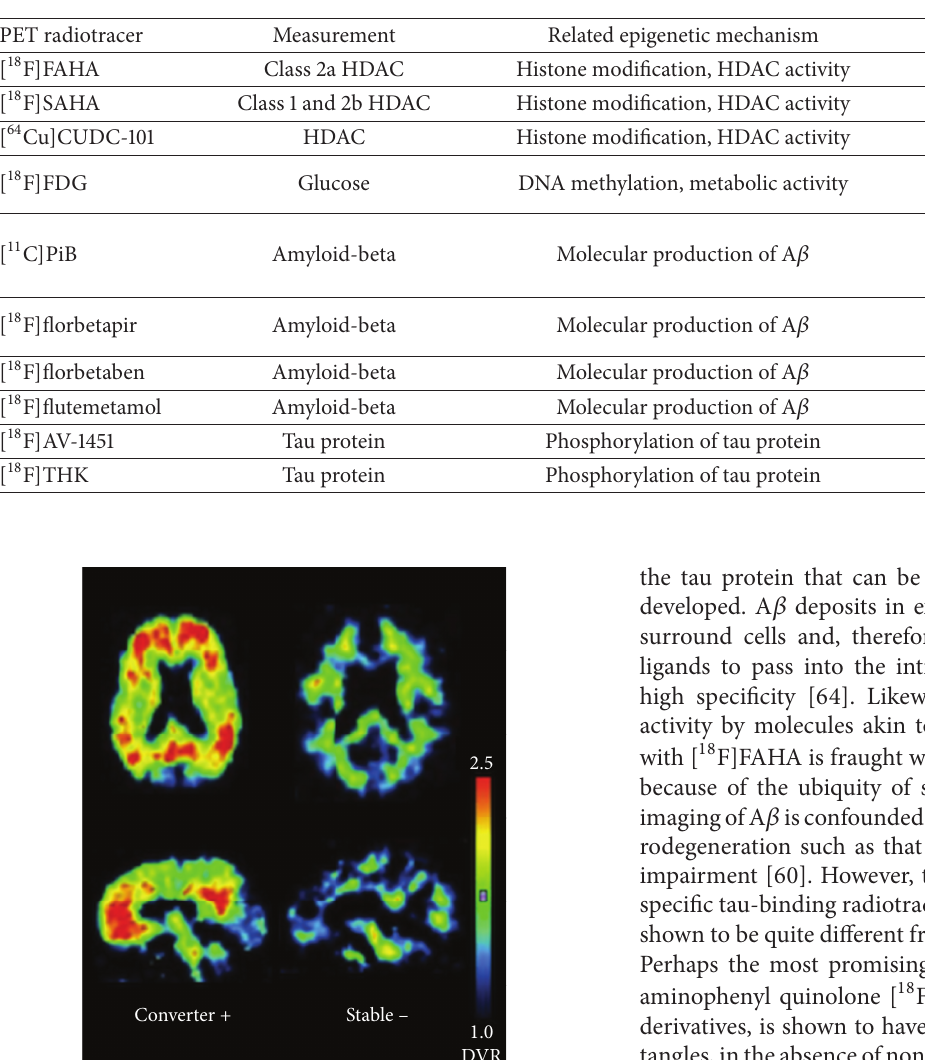
Table 1: PET radiotracers for visualizing epigenetic influences on Alzheimer’s disease.